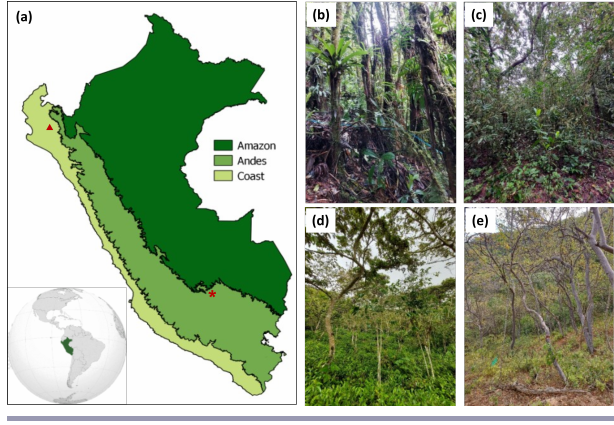
Fig. 1. (A) Map of Peru showing the coastal, Andean, and Amazonian regions. Photographs showing mature forest (B), secondary forest regrowth following tea plantation (C), and a tea agroforestry system (D), all located in the Huayopata District, Cuzco region (indicated by an asterisk in panel A). (E) Photograph of coastal dry secondary forest located in the Mangamanguilla Private Conservation Area, Piura region, in northwestern Peru (indicated by a triangle in panel